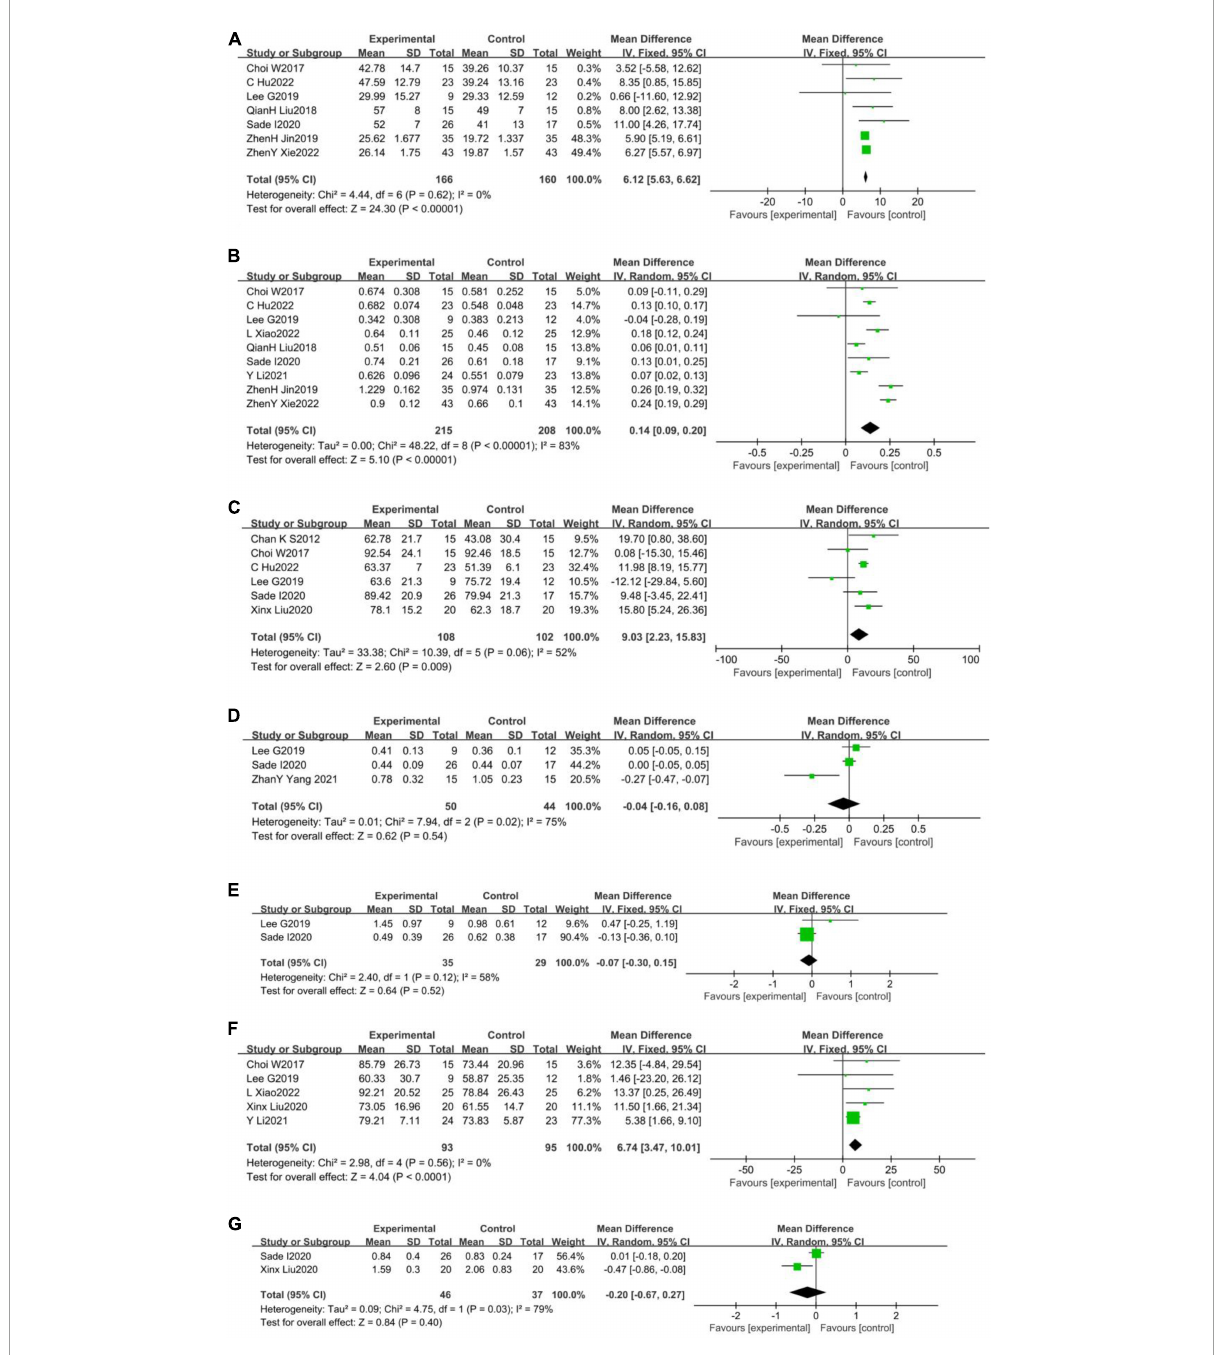
FIGURE3 Forest plot of the effects of WBV training on walking spatiotemporal parament. (A) Step length (cm); (B) step speed (m/s); (C) cadence (step/min); (D) single support time(s); (E) double support time (s); (F) stride length (cm); and (G) step time